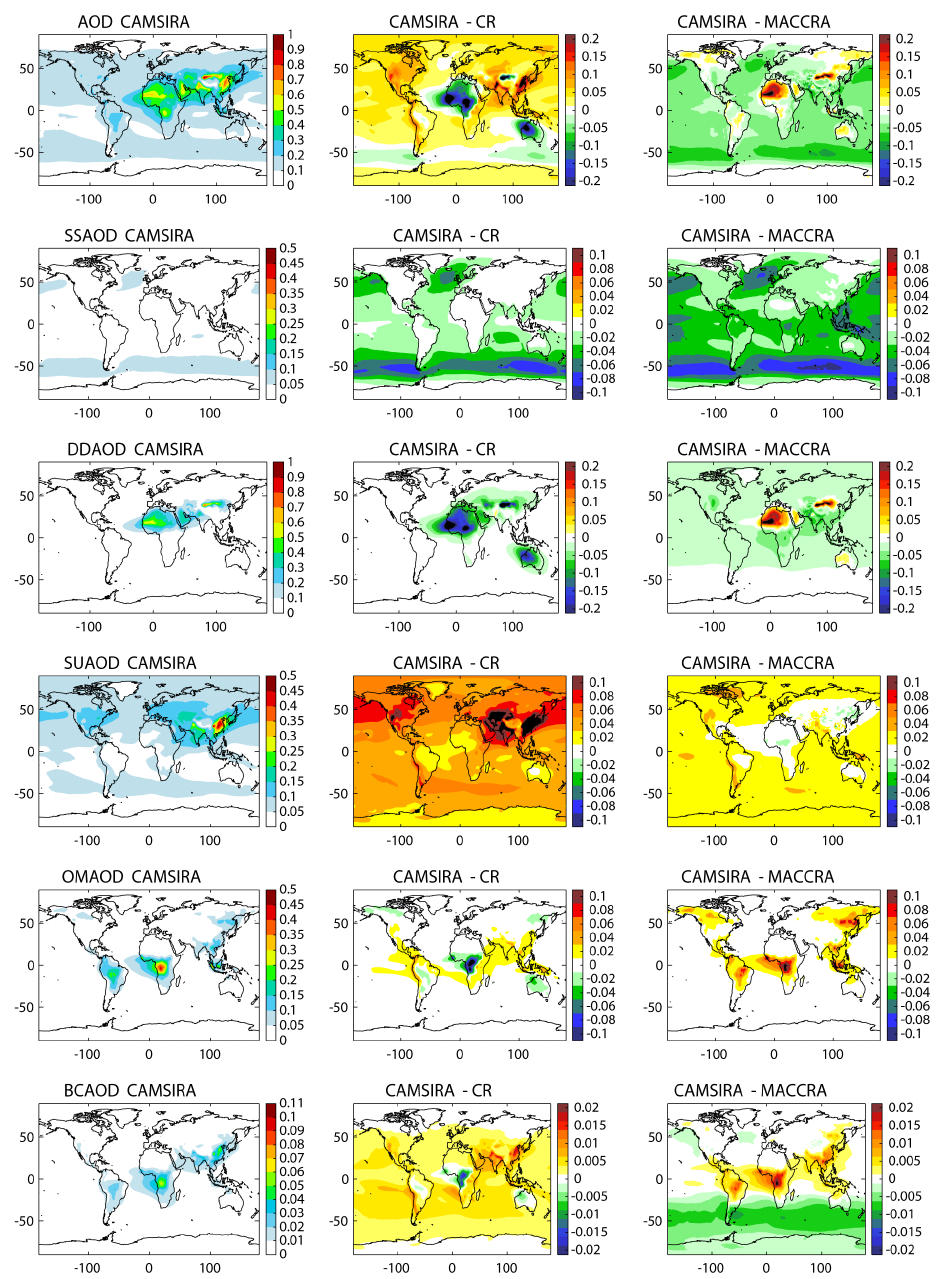
Figure 8. Total average AOD (row 1, scale max 1.0), AOD of desert dust (row 2, 1.0), sea salt (row 3, 0.5), sulfate (row 4, 0.5), organic matter (row 5, 0.5), and black carbon (row 6, 0.11) of CAMSiRA (average 2003–2015, left) and differences compared with the CR (average 2003–2015, middle) and MACCRA (average 2003–2012,